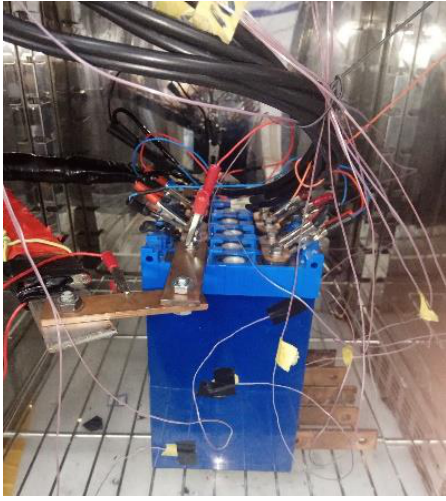
Figure 2. Experimental model in natural state.